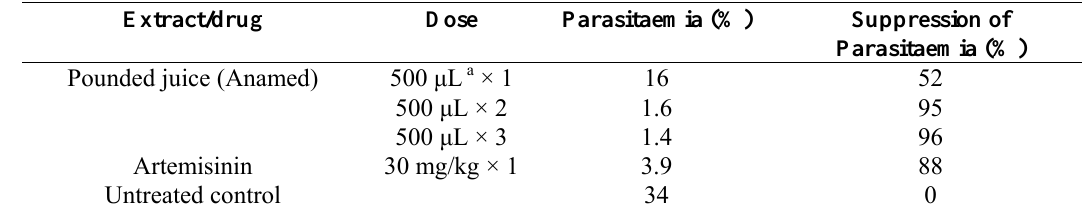
Table 2. In vivo evaluation of orally administered fresh pounded juice (Anamed) against P. berghei in